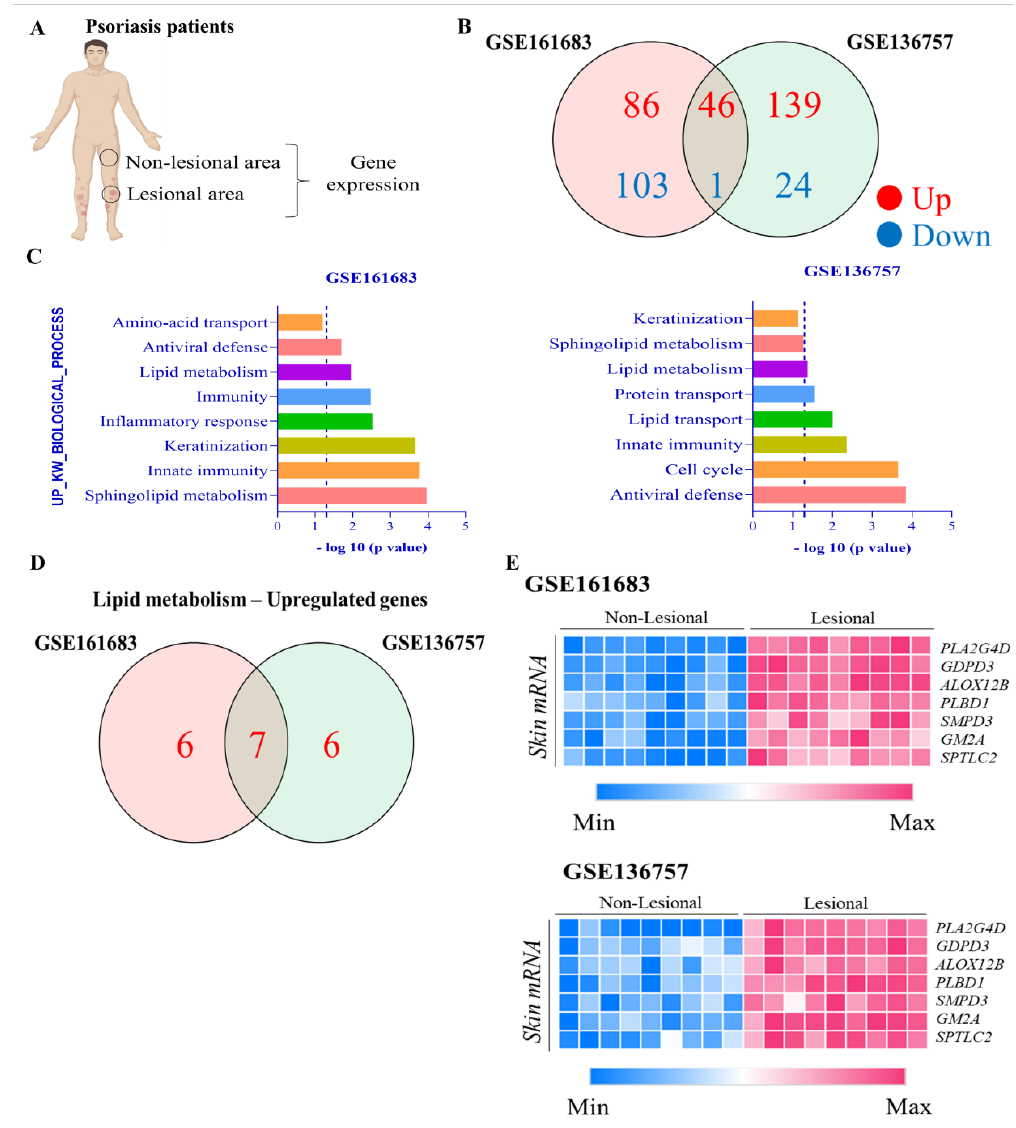
Figure 3. Importance of lipid metabolism in biological processes in psoriasis lesioned skin. ( A ) The gene expression as analyzed in non-lesioned and lesioned skin of patients with psoriasis from GSE161683 and GSE136757. ( B ) Venn diagram showing up- and down-regulated genes in the two datasets. ( C ) Up-regulated biological process. ( D ) Venn diagram showing up-regulated genes re- lated to lipid metabolims in the two datasets. ( E ) Heat map showing expression gene profiles com- paring non-lesional and lesional skin from the GSE161683 and GSE136757 datasets. In GSE161683, the researchers harvested NP and LP skin from nine patients with psoriasis. In addition, another nine patients from GSE136757 were analyzed. All of the gene expression profiling was analyzed using microarray analysis. The sample basic in- formation of GSE161683 included the following: male and female patients with psoriasis vulgaris aged 33 – 56 years and PASI score of 12 [67]. For GSE136757, it included the fol- lowing: male and female patients with plaque psoriasis aged 18 – 65 years with a PASI score of 12 [68]. In the present study, the differentially expressed genes (DEGs) were searched using GEO2R, an interactive web tool to identify genes that are differentially expressed across experimental conditions. This interface performs the comparisons on original submtter-